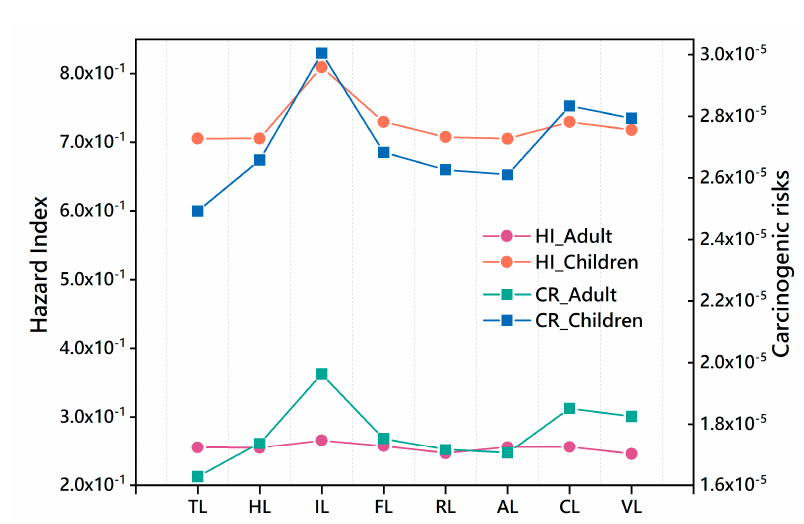
Figure 8. Carcinogenic risk index and non-carcinogenic risk index for adults and children under different land-use types. di ff erent land-use